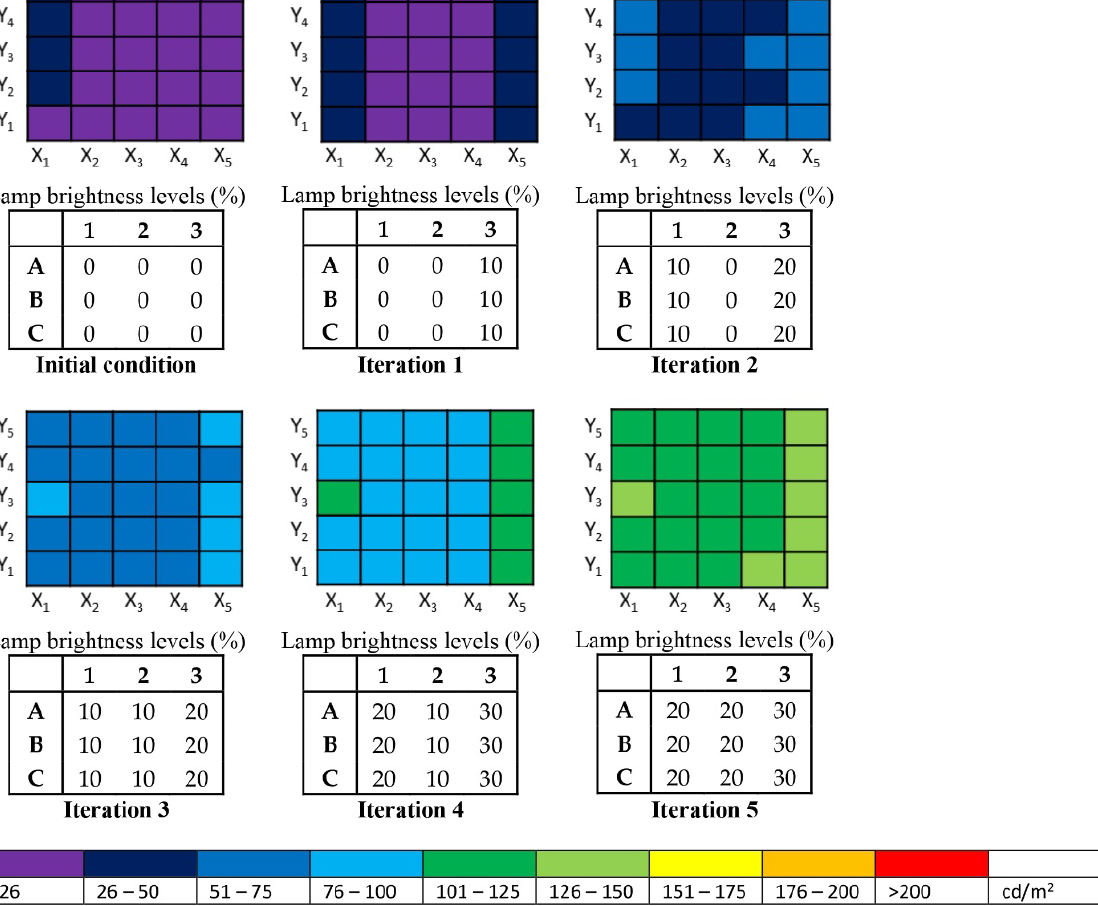
Figure 10. The luminance values and lamp brightness levels for Measurement Scheme 1B.